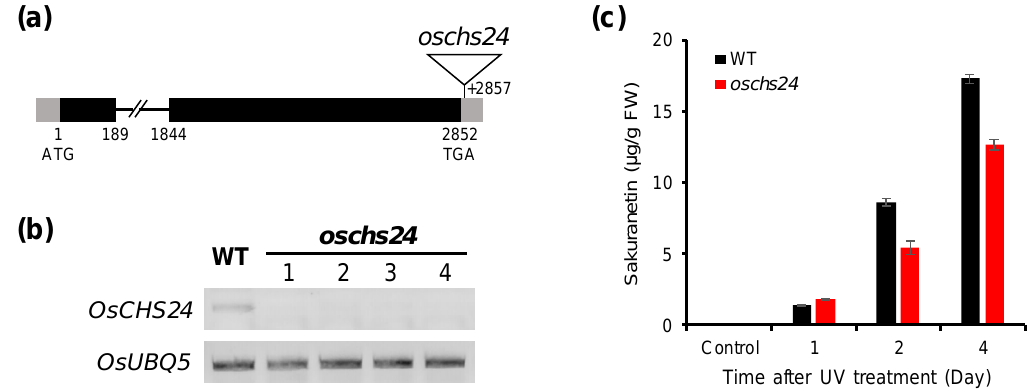
Figure 5. Characterization of the oschs24 mutant. ( a ) The gene structure of OsCHS24 showing the T-DNA insertion position of the oschs24 mutant. Black boxes, gray boxes, and lines between boxes indicate exons, UTRs and introns, respectively. A triangle represents the position of the T-DNA insertion in oschs24 . ( b ) RT-PCR analysis of OsCHS24 expression in the leaves of homozygous oschs24 mutants. The homozygous oschs24 plants showed the suppressed expression of OsCHS24 . OsUBQ5 was used as an internal control. ( c ) Accumulation of sakuranetin in wild-type and oschs24 mutant in response to UV irradiation. The leaf samples were collected from UV-treated rice plants 1, 2, and 4 days after UV irradiation. Analyses of the sakuranetin contents were performed on triplicate biological samples. The results represent the mean ± standard deviation. FW; fresh weight.